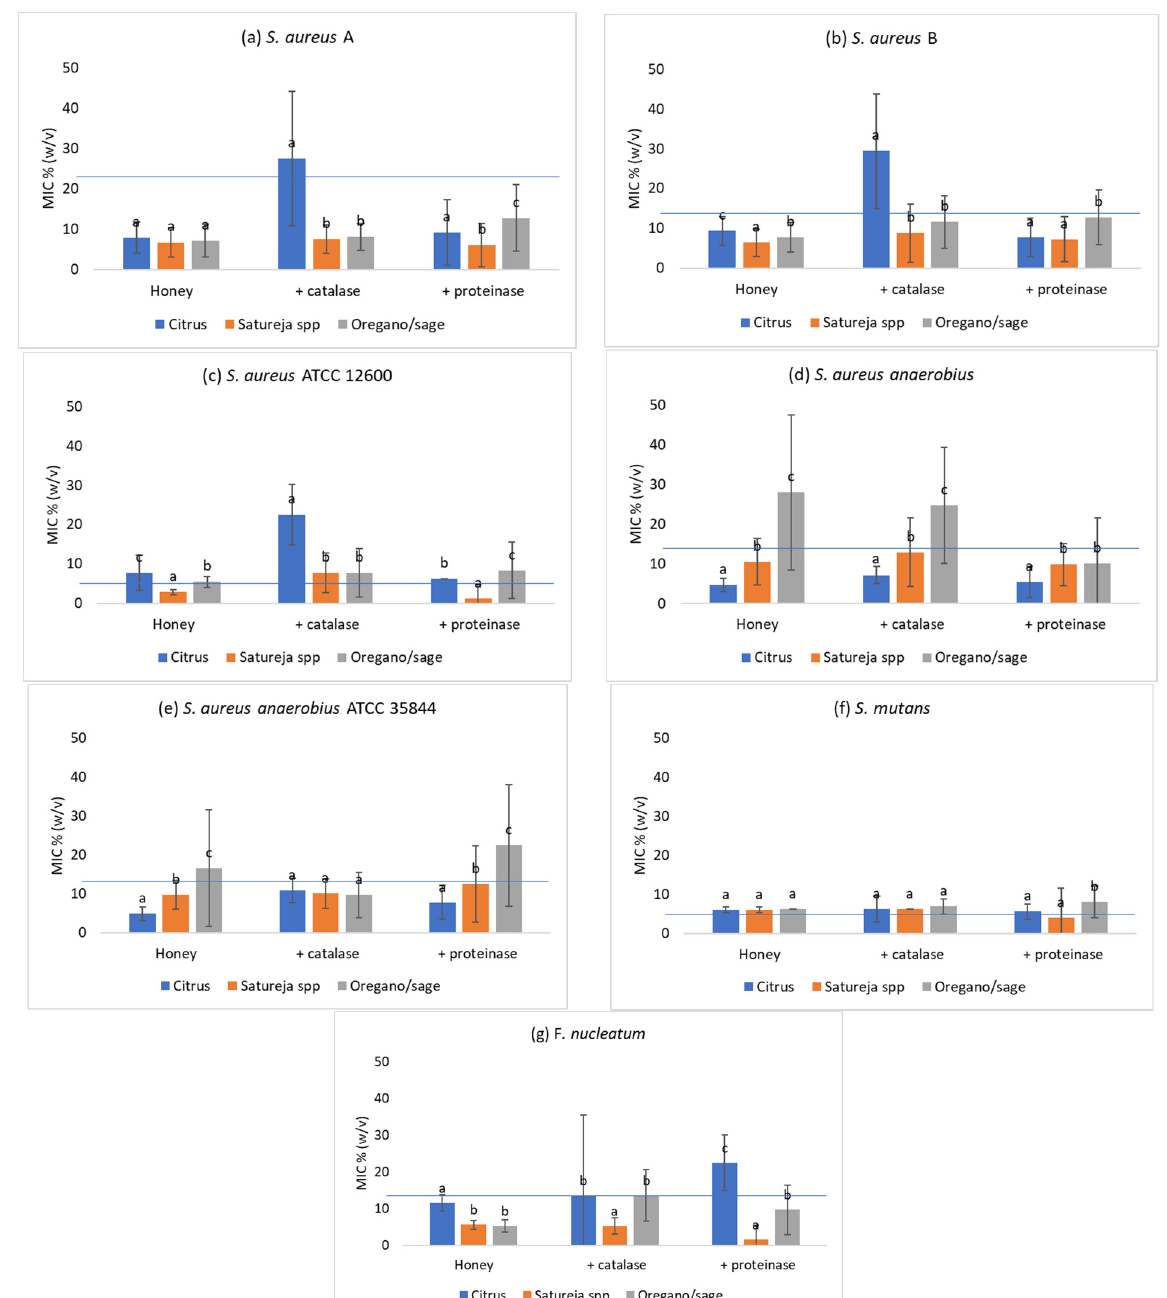
Figure 3. ( a – g ): Minimum inhibitory concentration of local ( n = 60) honey samples treated with and without catalase or proteinase as well as manuka honey ( n = 1) against seven oral pathogens with artificial saliva as diluent. Different letters indicate differences among the types of honey within each treatment. Line (blue) indicates the MIC value of manuka.